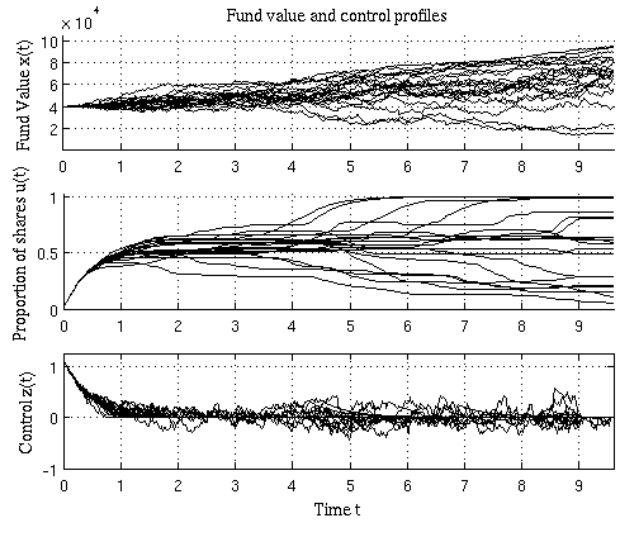
Figure 7. Sample of fund value, proportion of shares and shares’ adjustments for b = 0 . 01